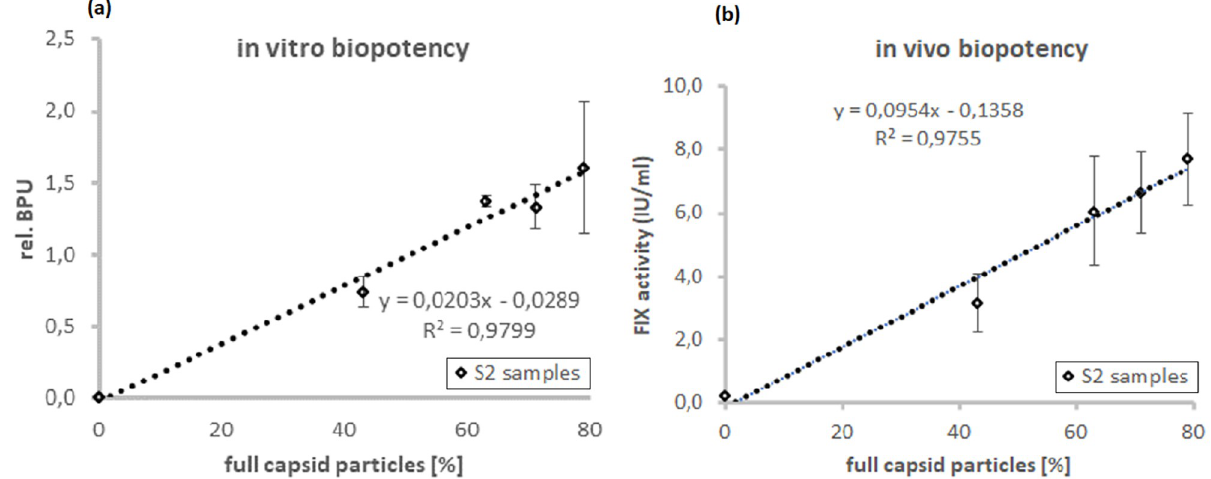
Fig 2. Correlation between CryoTEM and biopotency. Correlation between the in-vitro biopotency (a) and in-vivo biopotency (b) of the drug and the percentage of full particles as detected by CryoTEM for a set of specimens with varying ratios of full particles.